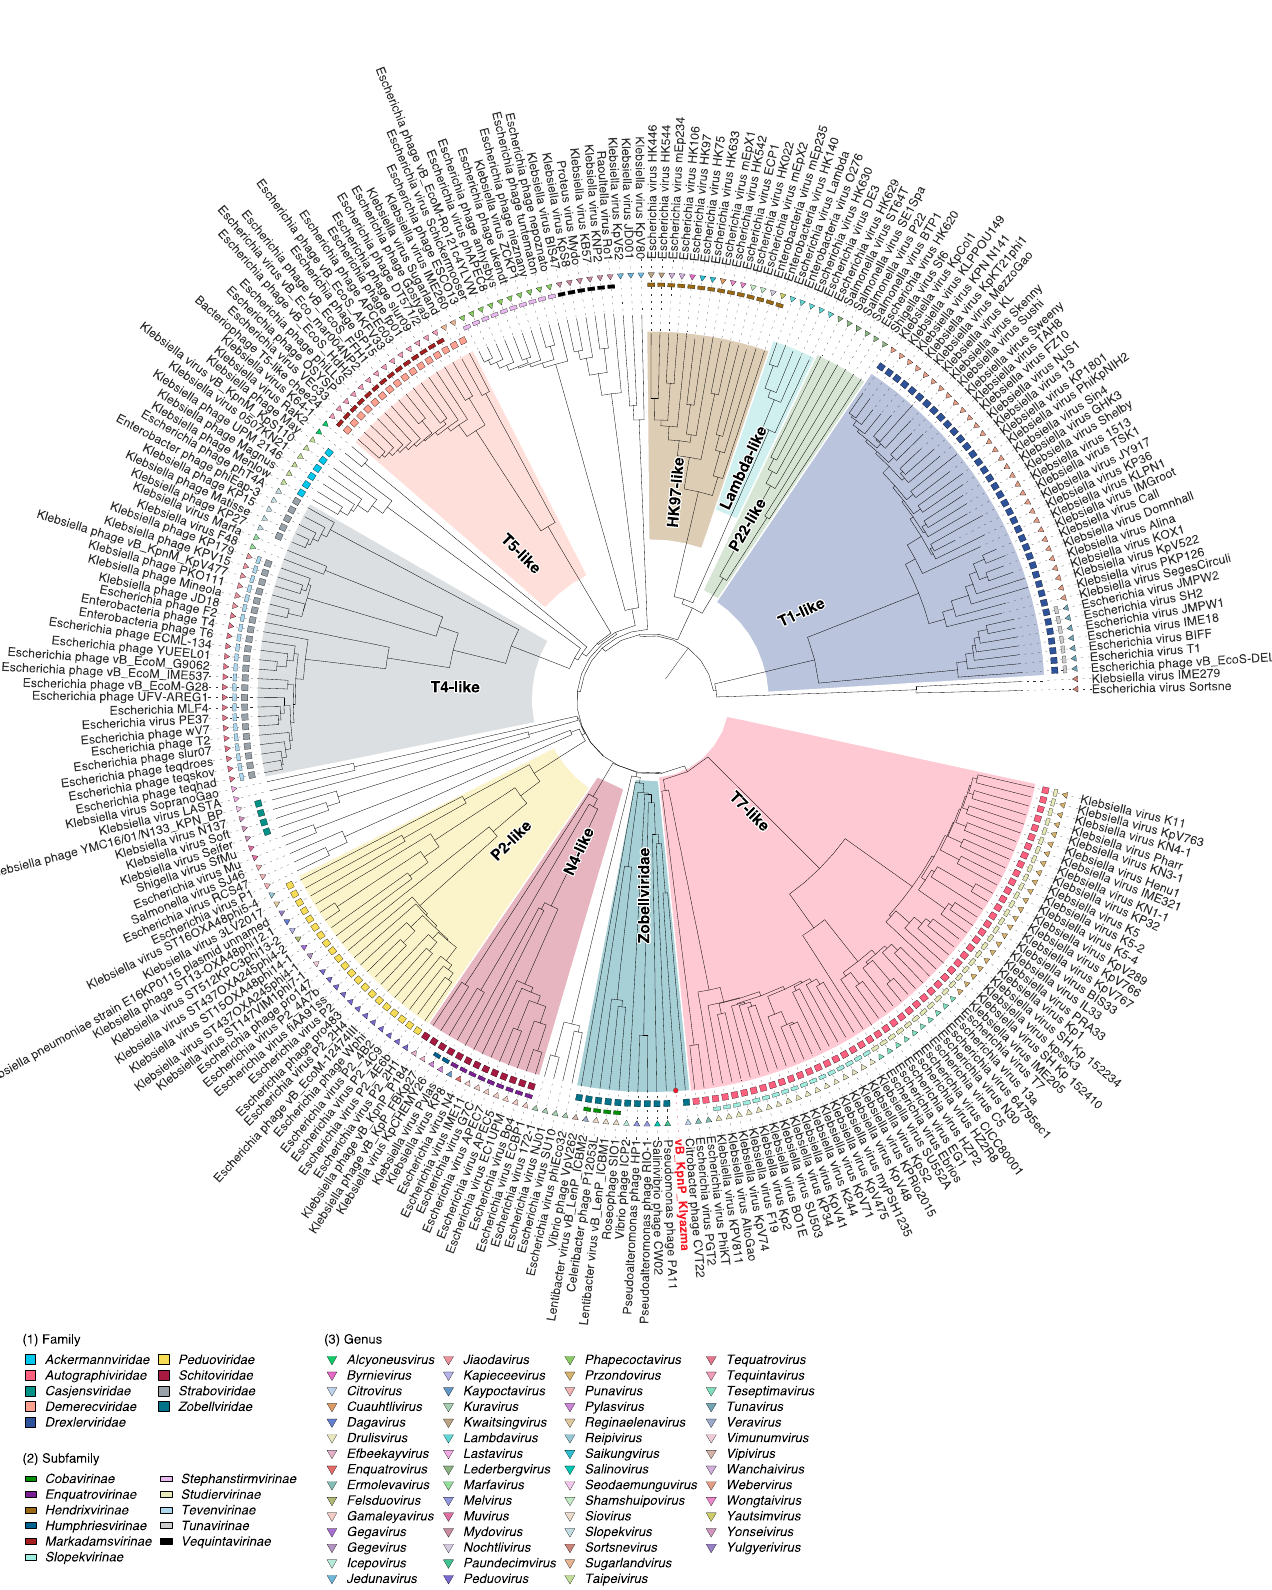
Figure 3. ViPTree analysis of vB_KpnP_Klyazma (highlighted in red) and related phages. Phages are identified according to their official ICTV classification.